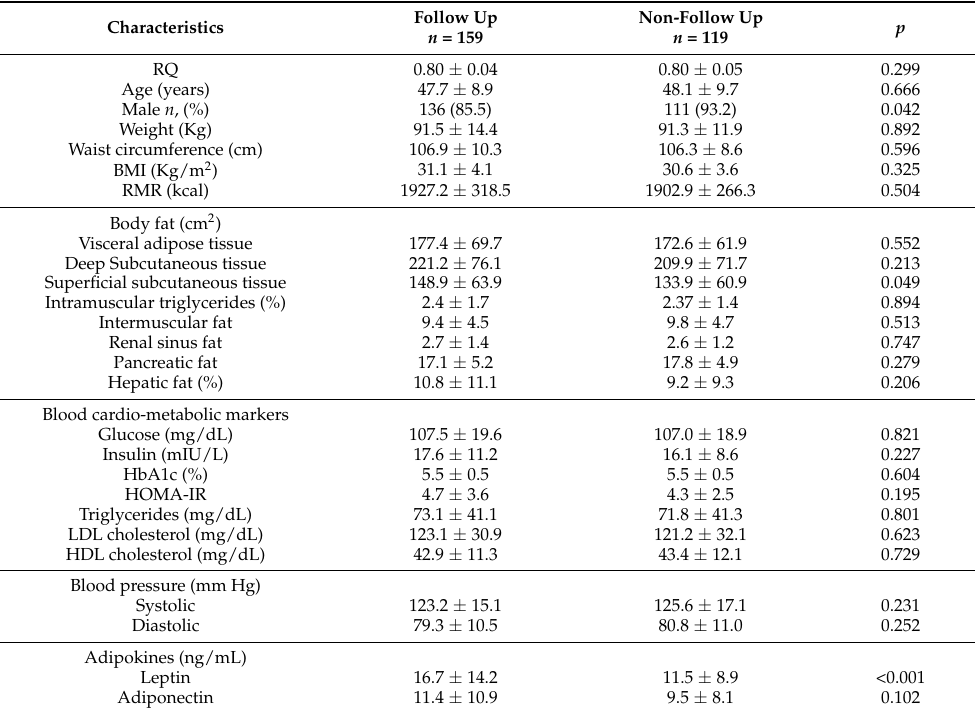
Table A1. Baseline characteristics comparison between participants with and without six-month follow up assessment.